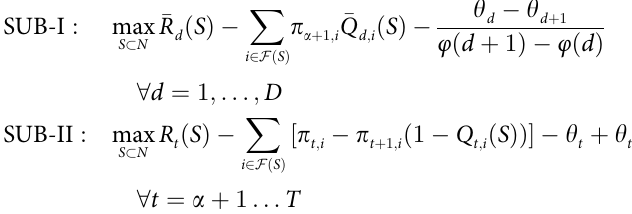
Algorithm 1 Dynamic Disaggregated (DD) Approach